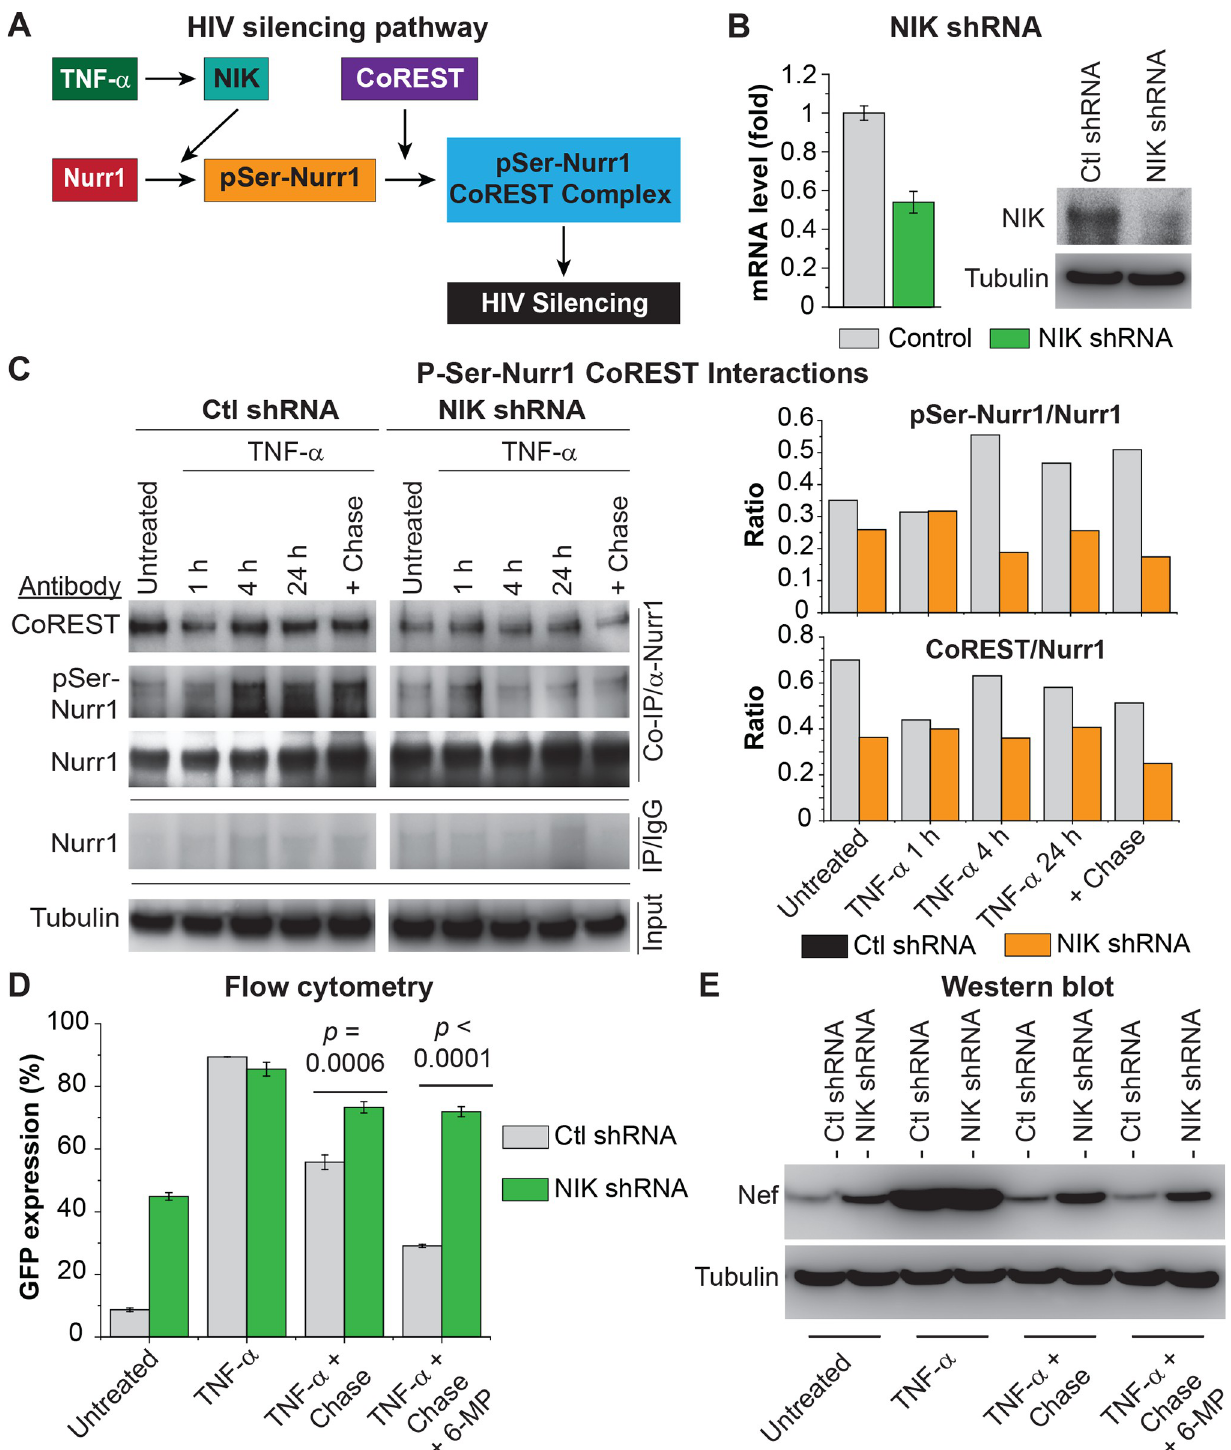
Fig 10. TNF- α stimulation induces Nurr1 phosphorylation by NIK, which triggers its association with CoREST repressor complex for HIV silencing. A, schematic presentation of TNF- α induced Nurr1 phosphorylation and its association with CoREST for HIV silencing. B Knock down (KD) of NIK in HC69 cells with NIK specific shRNAs (Santa Cruz Biotech, Cat# sc-36079V) and control shRNA respectively. Left: The relative levels of NIK mRNA from HC69 cells expressing control shRNA (grey bars) and NIK shRNA (green bars) was measured by qRT-PCR using the primers 5’ TGCGGAAAGTGGGAGATCCTGAAT 3’ (forward) and 5’ TGTACTGTTTGGACCCAGCGATGA 3’ (reverse). Expression levels were then normalized